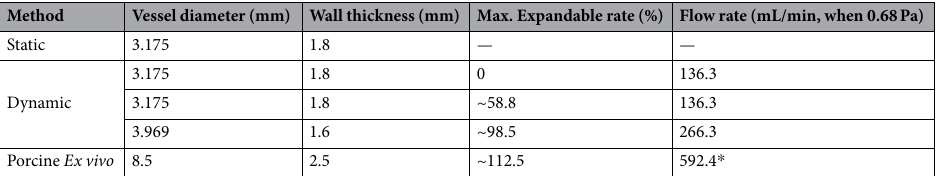
Table 1. Experimental conditions for in vitro artificial vessel and ex-vivo artery. * Flow rate (mL/min) was operated according to the 0.154